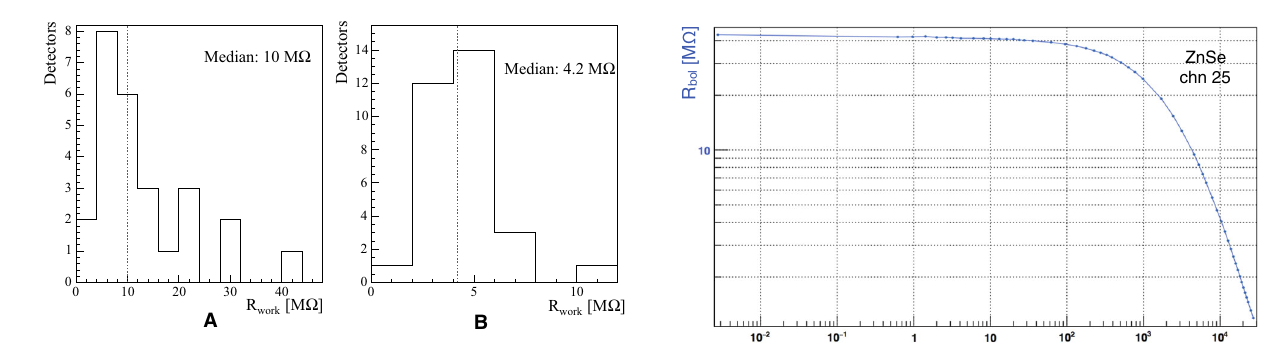
Fig. 21 Distribution of the Ge-NTD sensor resistances for ZnSe ( a ) and LD ( b ) at the operating conditions